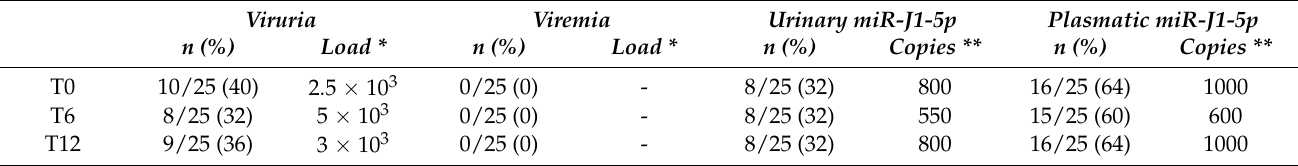
Table 2. JCPyV viruria, viremia, anti-JCV index and miRNAs expression: longitudinal investigation among healthy control subjects